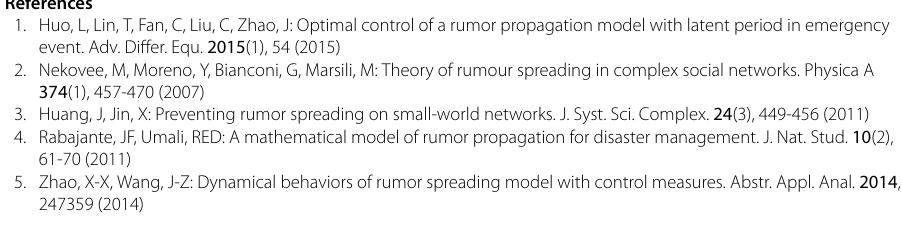
Figure 8 Instability diagram and periodic solutions for system (1) when τ = 1 and β 1 =